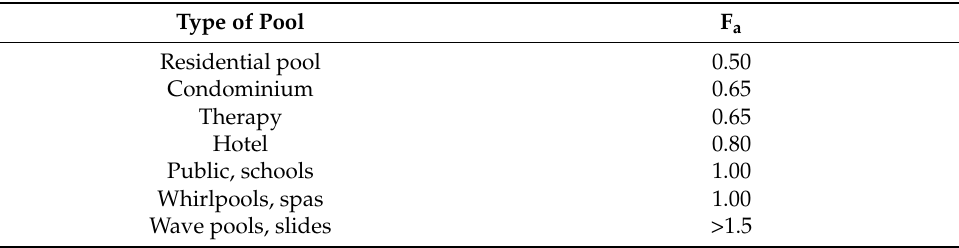
Table 15. Typical activity